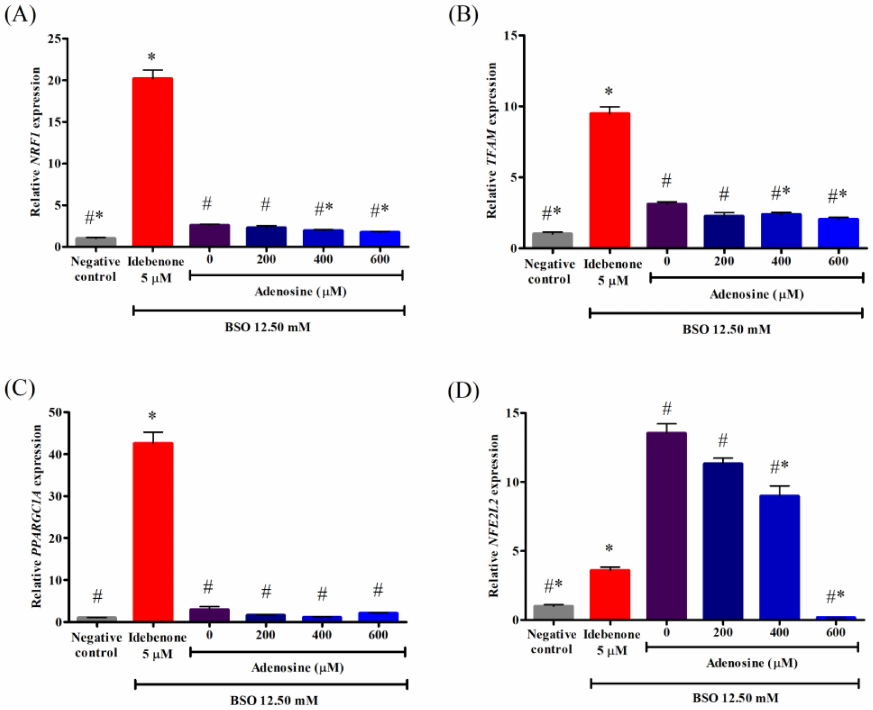
Figure 6. Effects of adenosine on the relative gene expressions associated with mitochondrial biogen- esis in FRDA fibroblasts treated with BSO. Gene expressions of ( A ) NRF1 , ( B ) TFAM , ( C ) PPARGC1A , and ( D ) NFE2L2 were evaluated by RT-qPCR following pre-treatment with adenosine for 2 h and 12.50 mM BSO for 24 h. Data are expressed as mean ± SD and statistically analyzed by one-way ANOVA with Games–Howell post-hoc test. Hash (#) and asterisk (*) indicate significant differences ( p < 0.05) in the relative gene expressions compared to the idebenone group and BSO-treated (0 µ M adenosine) group, respectively. BSO, L-buthionine sulfoximine; NFE2L2 , nuclear factor-erythroid 2-related factor 2; NRF1 , nuclear respiratory factor 1; PPARGC1A , PPARG coactivator 1 alpha; TFAM , transcription factor A,